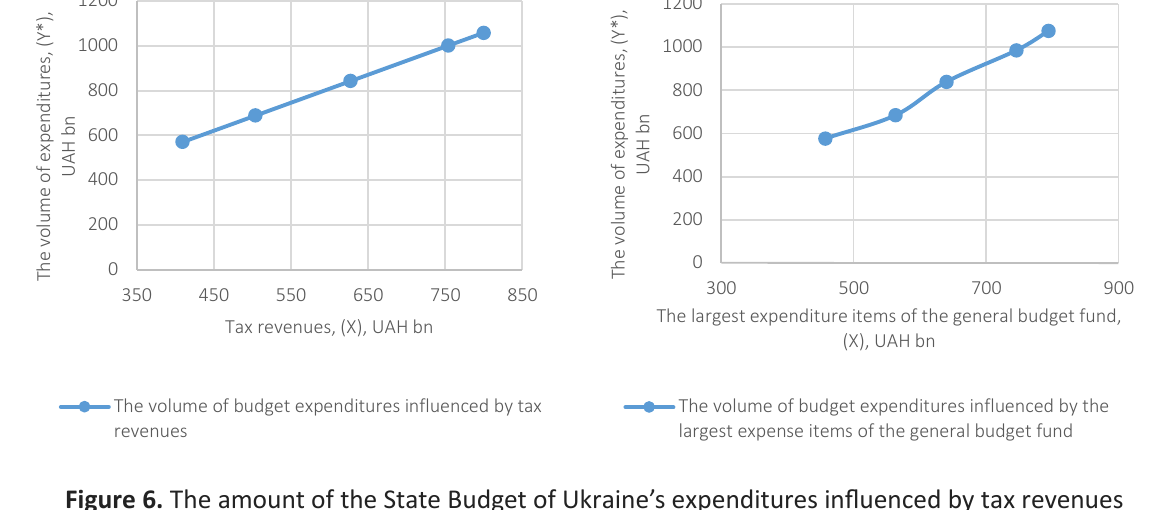
Figure 6. The amount of the State Budget of Ukraine’s expenditures influenced by tax revenues and the largest expenditure items of the general budget fund, UAH